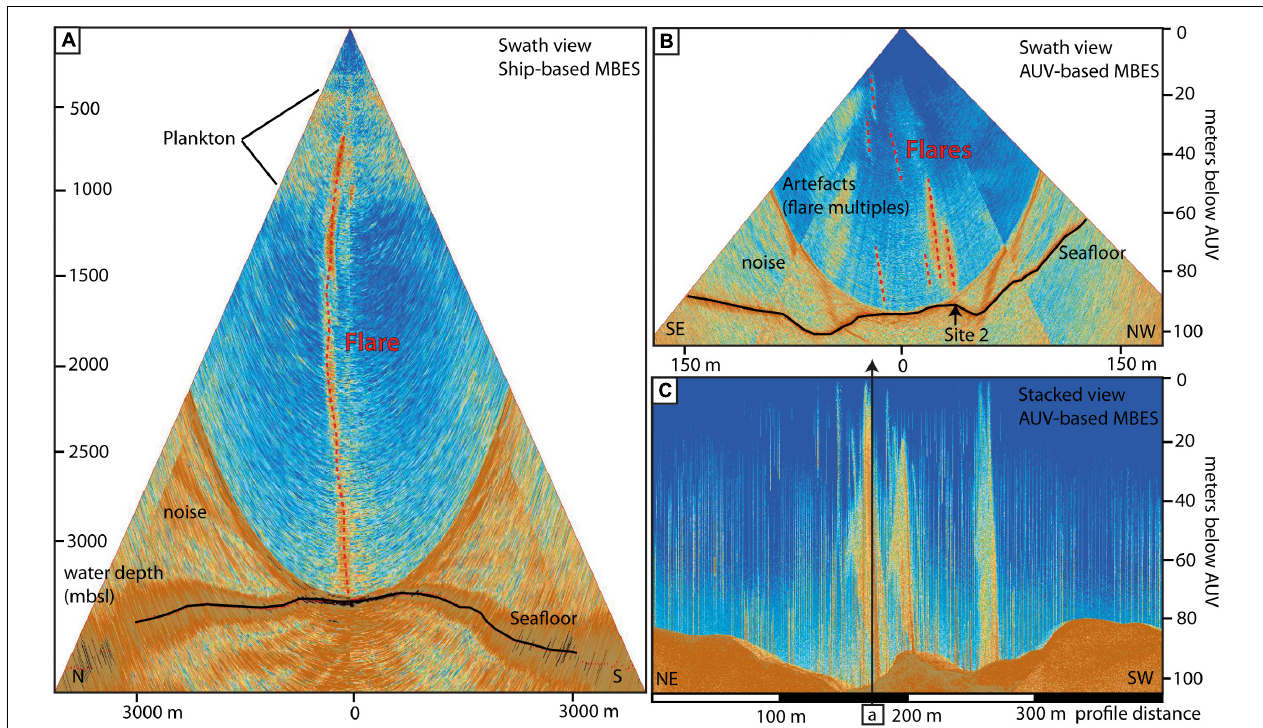
FIGURE 4 | Multibeam records illustrating water column observations at TYK. (A) Screenshot of ship-based data (presented in a ‘swath view’) showing the main flare at TYK that was detected to rise from the seafloor at 3400 mbsl to water depths of ca. 500 mbsl. (B) Screenshot of AUV-based multibeam data (‘swath view’) showing several flares (highlighted by dashed red lines) that were located above the northeastern depression of the main seep field. (C) AUV-based multibeam data (presented in ‘stacked view’) showing three major flare clusters (brownish colors) along a 400-m long survey line crossing the main seep field. Position of the swath view example shown in (B) is marked as black